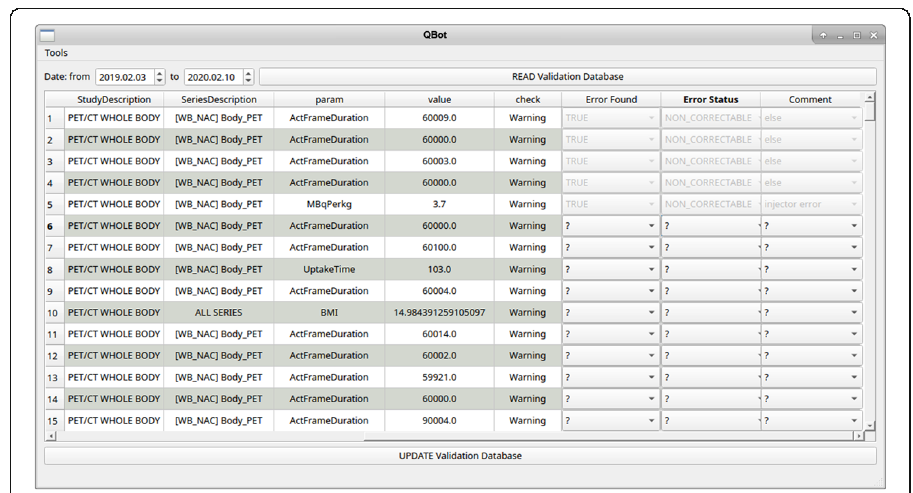
Fig. 3 Graphical user interface for listing and supervising records in the validation registry of Q-Bot. The three fields on the right are to be filled out after auditing the actual warning